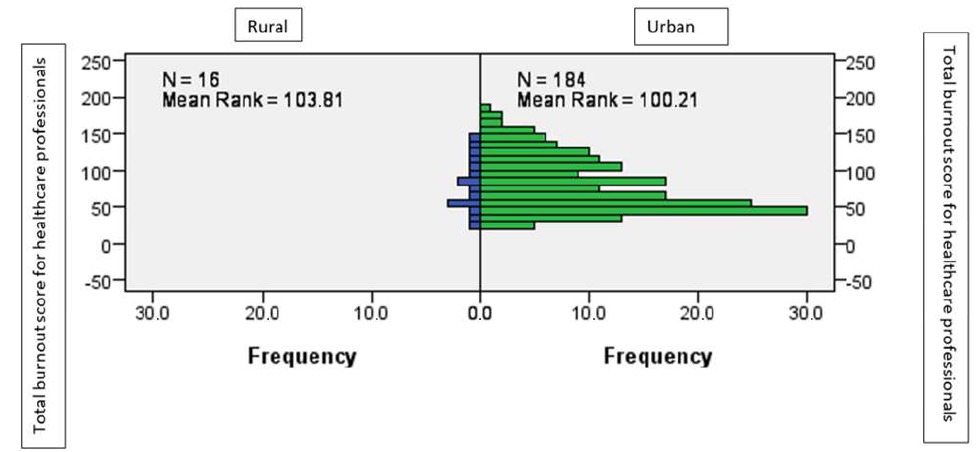
Figure 3. The average level of burnout according to workplace location.